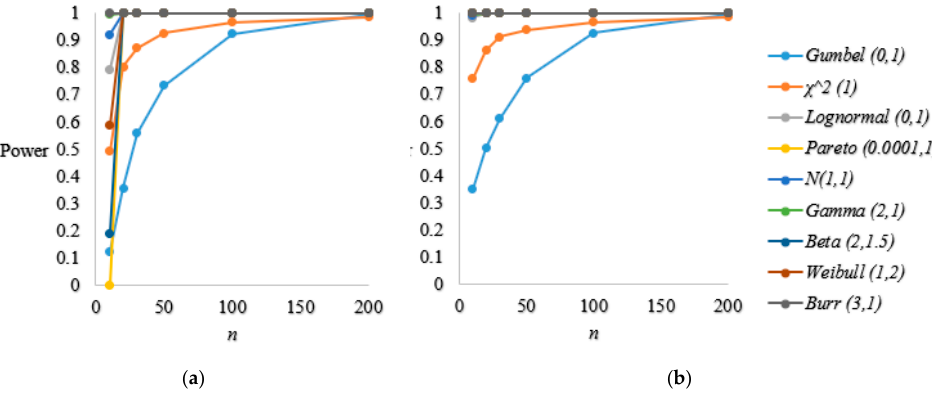
Figure 7. Empirical power of statistic 𝑉(cid:3364) (cid:3041) for various sample sizes with the level of significance 𝛼 = 0.05 —Asymmetric alternative distributions: ( a ) Parameters 𝜇 and 𝜎 (cid:2870) are known; ( b ) Parameters 𝜇 and 𝜎 (cid:2870) are estimated with 𝑋(cid:3364) (cid:3041) and 𝑆(cid:4634) (cid:3041)(cid:2870) , respectively.